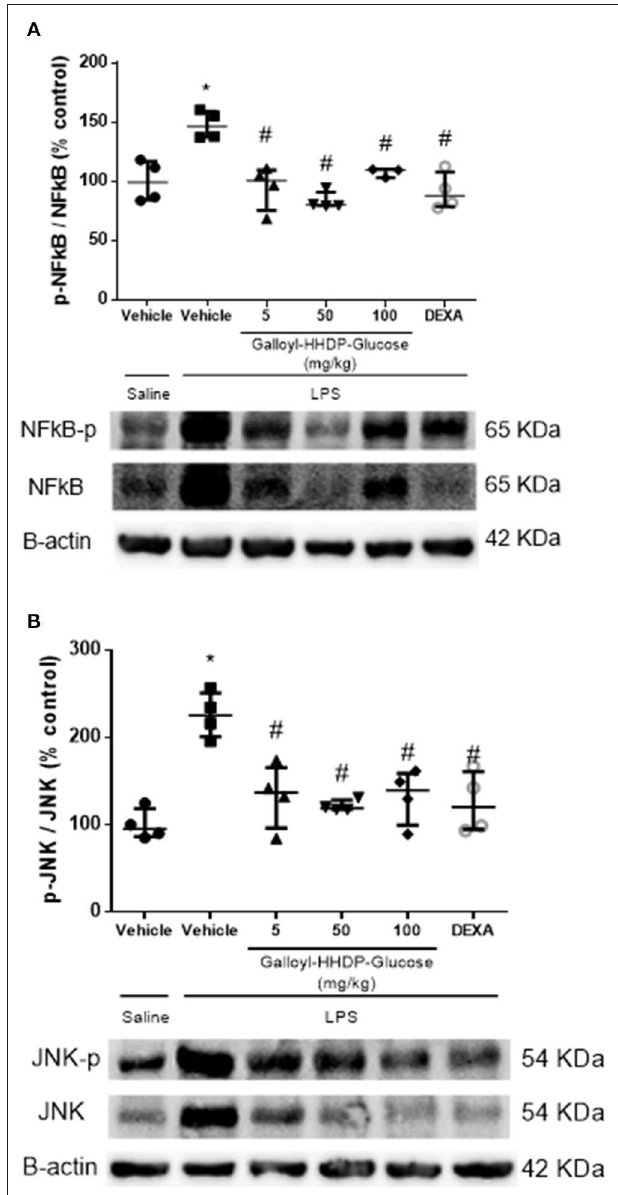
FIGURE 2 | Effects of galloyl-HHDP-glucose treatments on the activation of NF- κ B (A) and JNK (B) in the lungs of BALB/c mice. BALB/c mice were randomly allocated to 6 groups ( n = 4/group). Mice received galloyl-HHDP-glucose (5, 50, and 100 mg/kg; p.o), dexamethasone (DEXA; 5 mg/kg; p.o), or vehicle (PBS, 10 mL/kg; p.o). The results were calculated as % increase relative to that in the control. β -actin was used as a